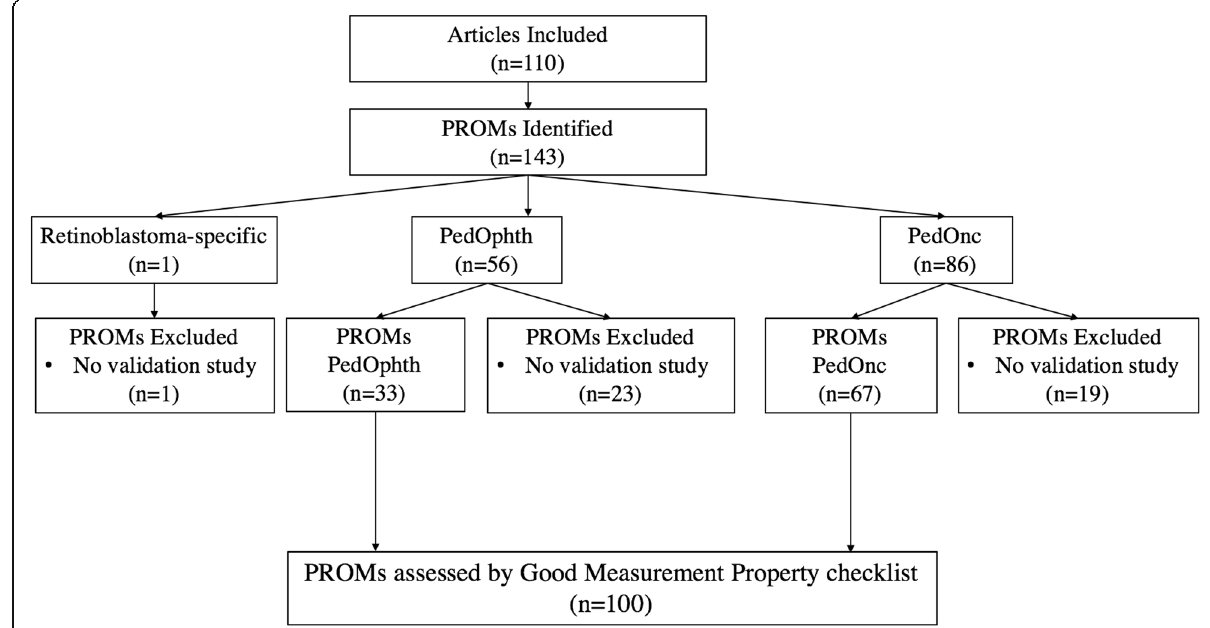
Fig. 2 PROM identification and breakdown, flow diagram. Of the PROMs identified for use in the populations of interest ( n = 143), validation articles ( n = 100) and were subsequently were identified for pediatric ophthalmology (PedOphth) and pediatric oncology (PedOnc) PROMs. PROMs were then assessed by the COSMIN good measurement property checklist for methodologic